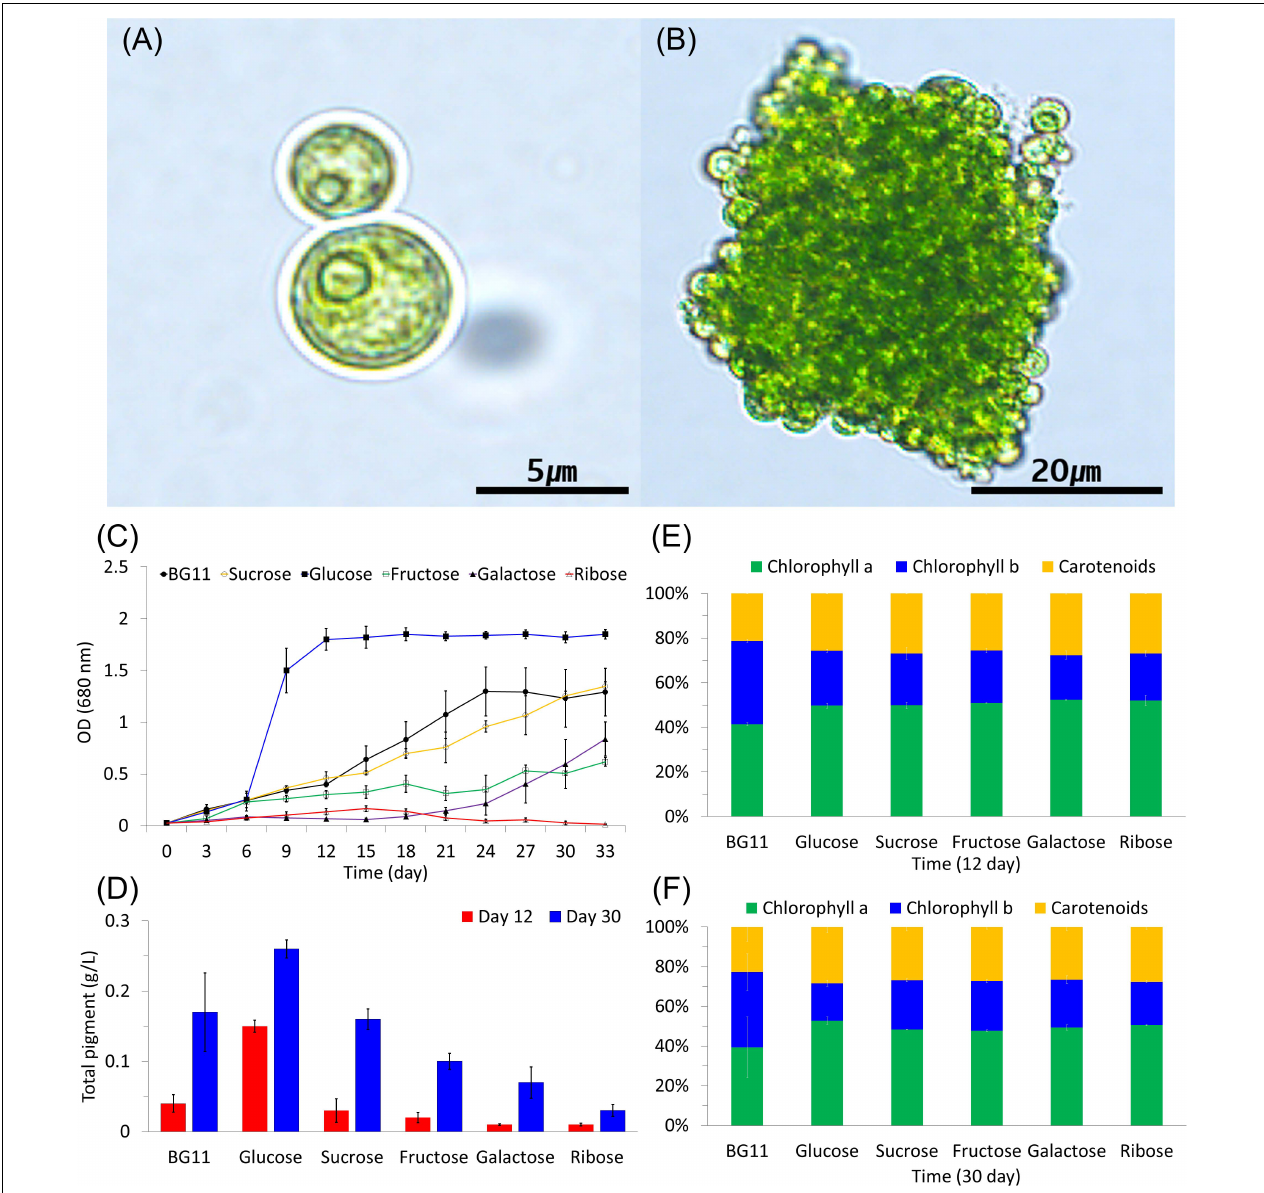
FIGURE 1 | Light microscopic images of Botryosphaerella sudetica KNUA107. Under photoautotrophic conditions, B. sudetica KNUA107 was observed as single cells (A) and colony-forming cells (B) . Pigment and chlorophyll contents were measured at 12 and 30 days after growth (C–F)